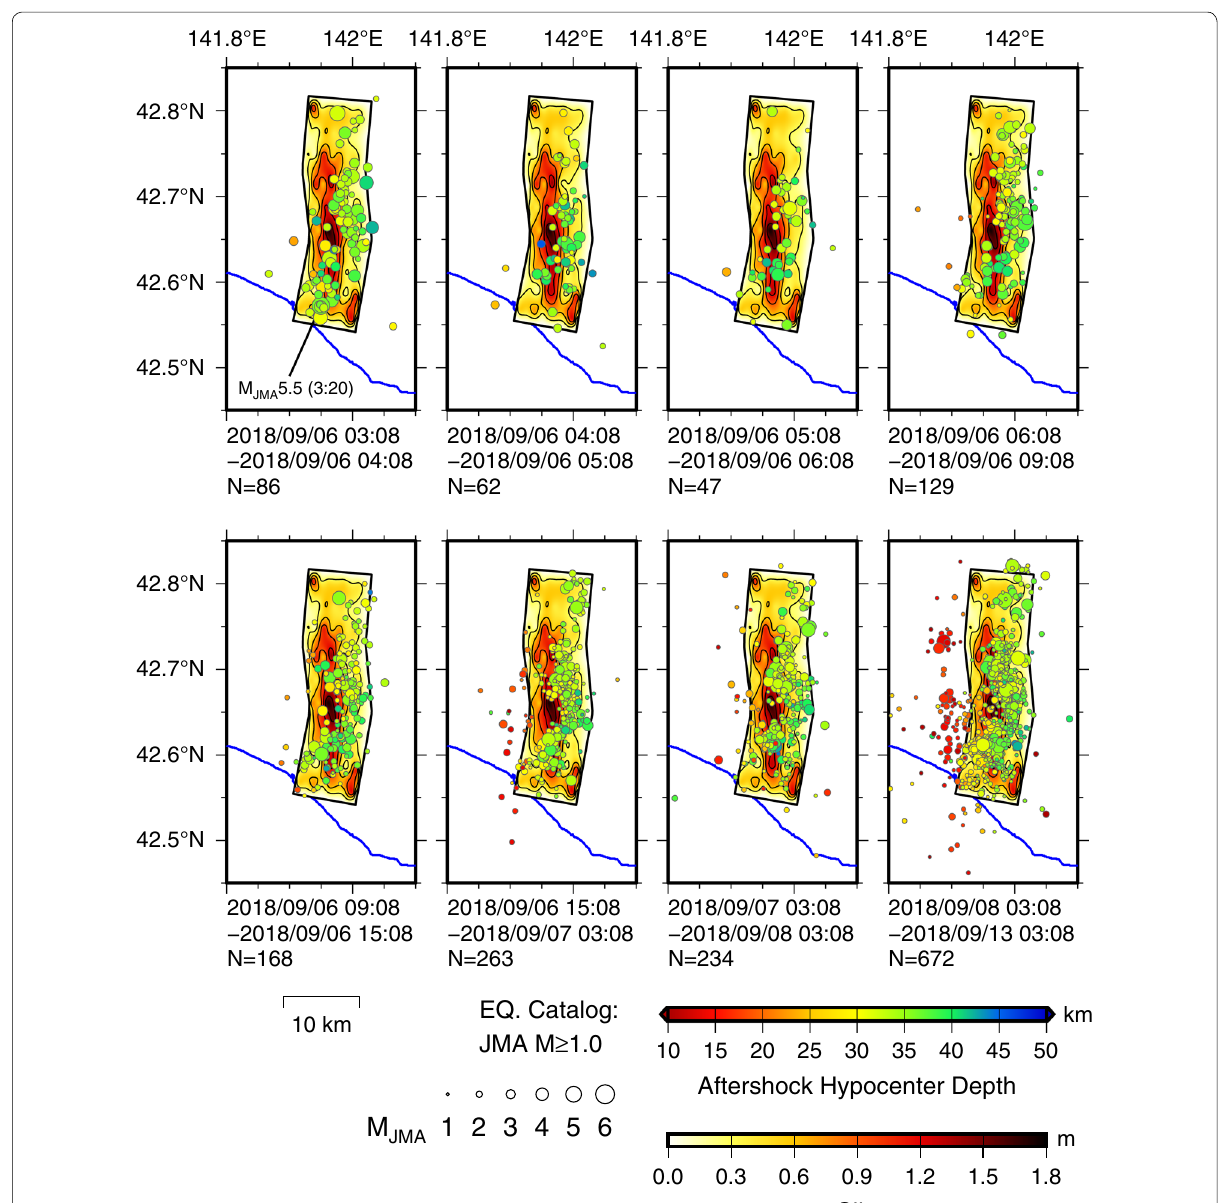
Fig. 8 Spatiotemporal distribution of the aftershocks ( M JMA > 1.0) compared with the final slip distribution of the